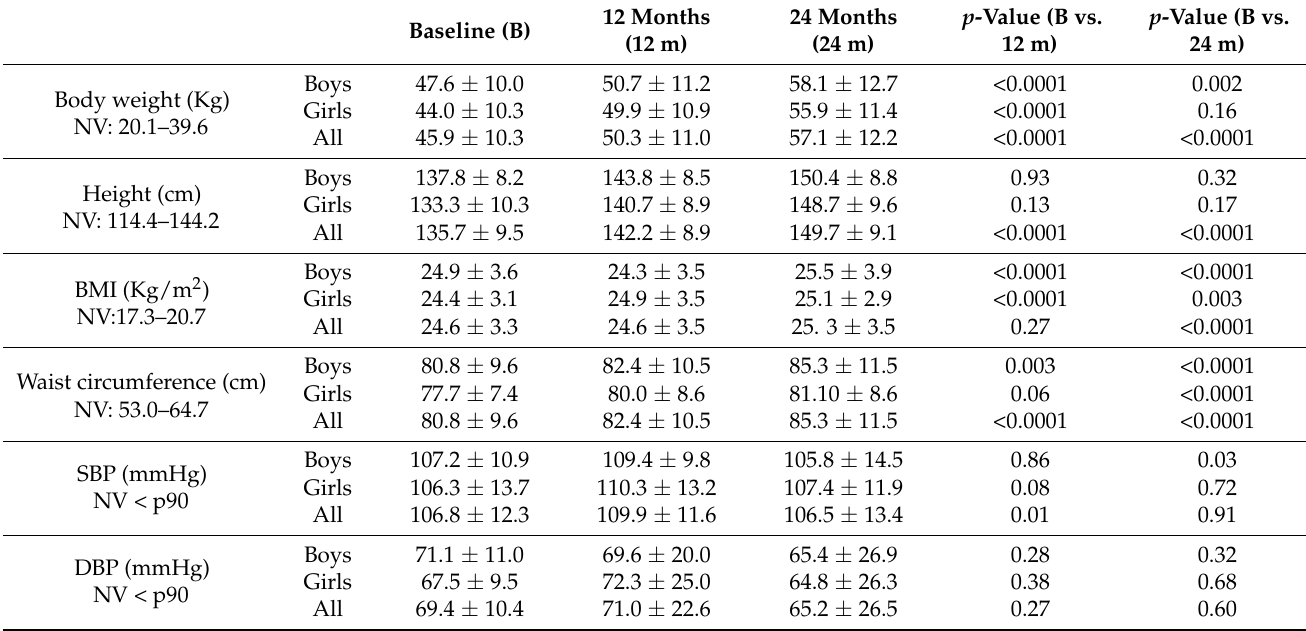
Table 1. Anthropometric parameters at baseline and after 12 and 24 months (m) of intervention in the total study population and by